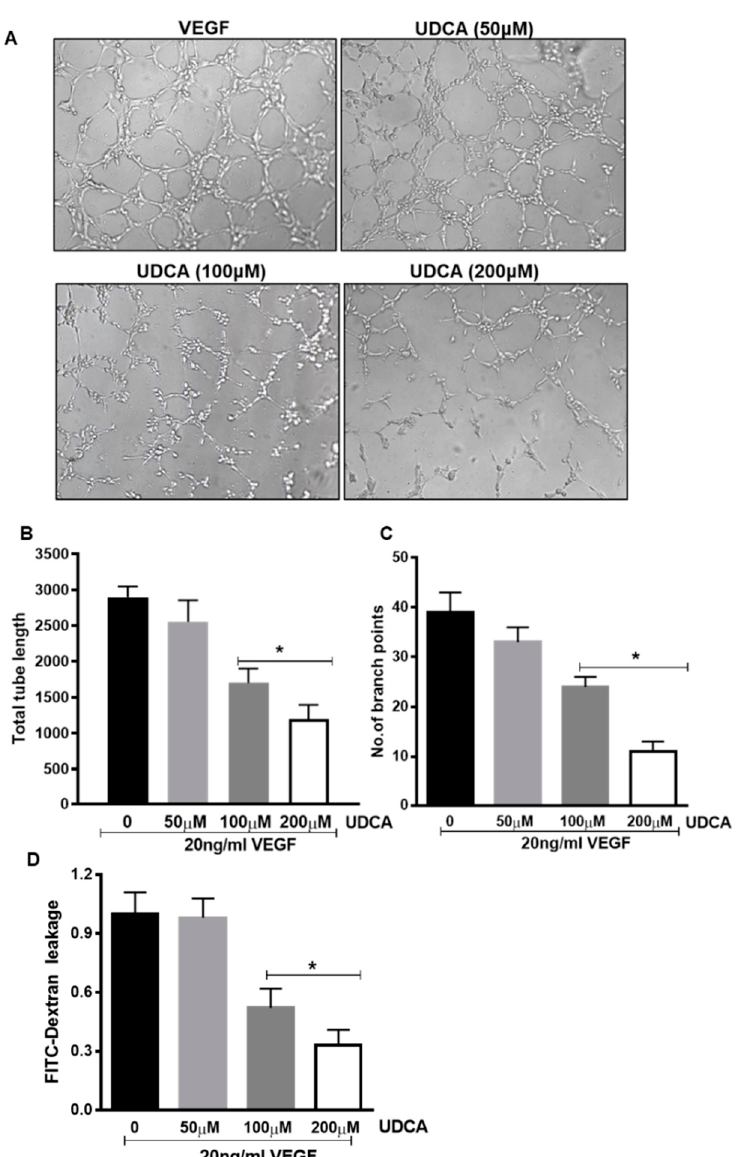
Figure 8. E ff ect of UDCA on in vitro tube formation and barrier function in VEGF-treated human retinal microvascular endothelial cells (HuREC). HuREC were maintained on matrigel-coated plates in the presence of 20 ng / mL VEGF alone or in combination with UDCA (50–200 µ M). ( A ) Micro images of tube formation assay. ( B , C ) Graphs representing results of ( B ) tube length and ( C ) number of branch points. Values are mean ± S.D ( n = 3). ( D ) Measurements of FITC (fluorescein isothiocyanate) fluorescence from HuREC grown in trans-well plates after treatment with 20 ng / mL VEGF in presence of di ff erent UDCA doses (50–200 µ M). * p < 0.05 vs. cells not treated with